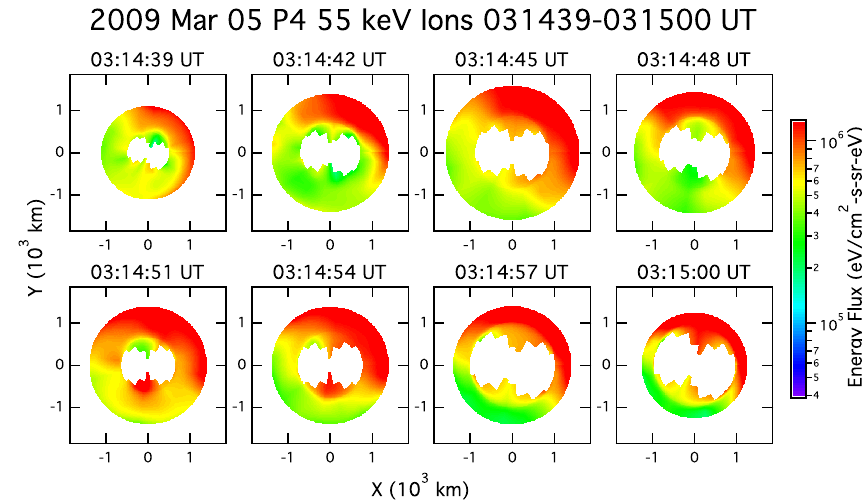
Fig. 7. Remote sensing of energization site for the current disruption/dipolarization event on 5 March 2009, with format same as Fig.